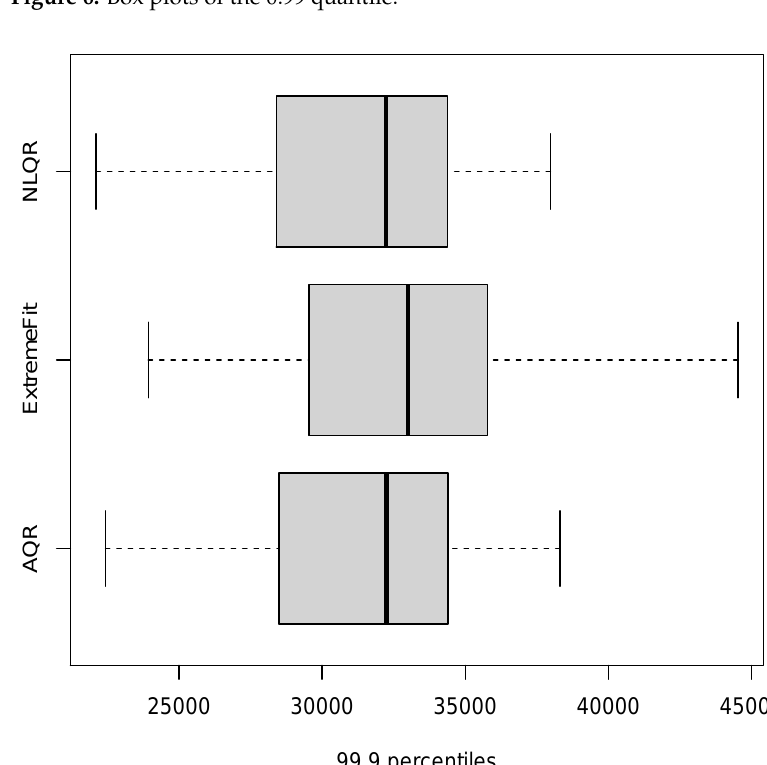
Figure 7. Box plots of the 0.999